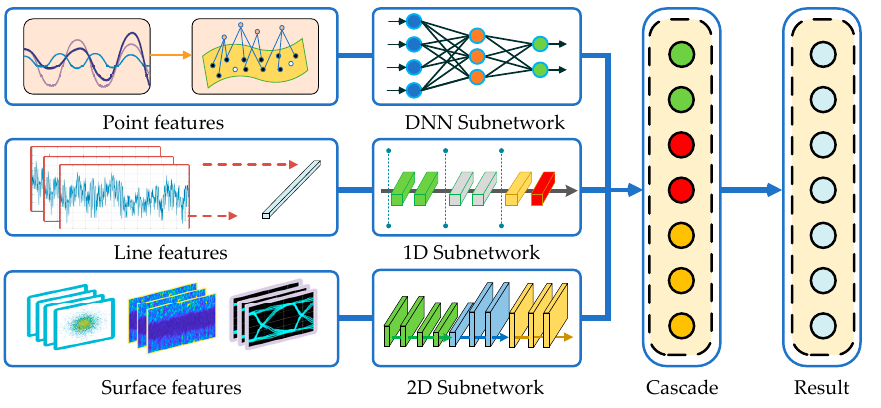
Figure 7. MFHN recognition framework.